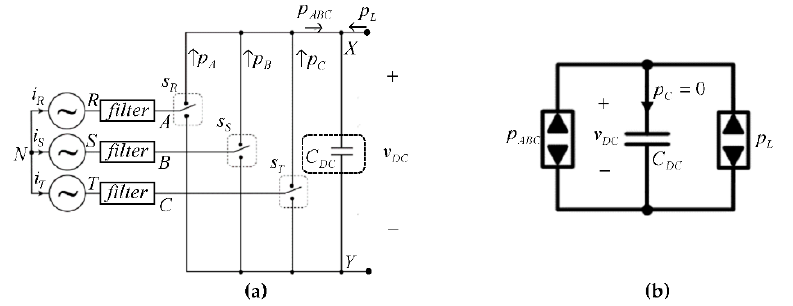
Figure 2. Two-level three-phase power conversion topology. ( a ) Generalized circuitry. ( b ) Power-level equivalent circuit of the DC link.